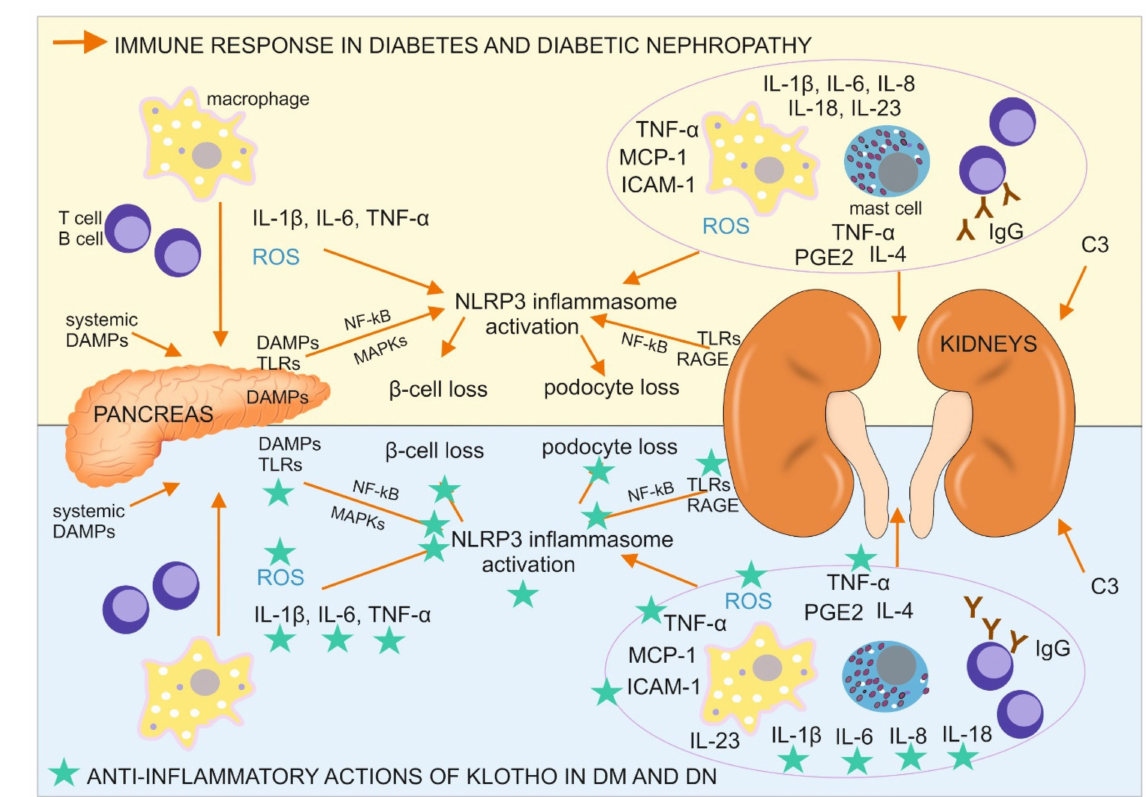
Figure 1. Immune response in diabetes mellitus (DM) and diabetic nephropathy (DN) with a designation of its tissue location, together with antiinflammatory actions of Klotho, directed on the cells, pathways, and proteins involved in the described immune response. C3, complement component 3; DAMPs, danger associated molecular patterns; ICAM-1, intercellular adhesion molecule 1; IgG, immunoglobulin G; IL, interleukin; MAPKs, mitogen-activated protein kinases; MCP-1, monocyte chemoattractant protein 1; NF- κ B, nuclear factor κ -light-chain-enhancer of activated B cells; NLRP3 inflammasome, a type of inflammasome that contains NACHT, LRR, and PYD domain-containing protein 3; PGE2, prostaglandin E 2 ; RAGE, receptor for advanced glycation endproducts; ROS, reactive oxygen species; TLR, Toll-like receptor; TNF- α , tumor necrosis factor α